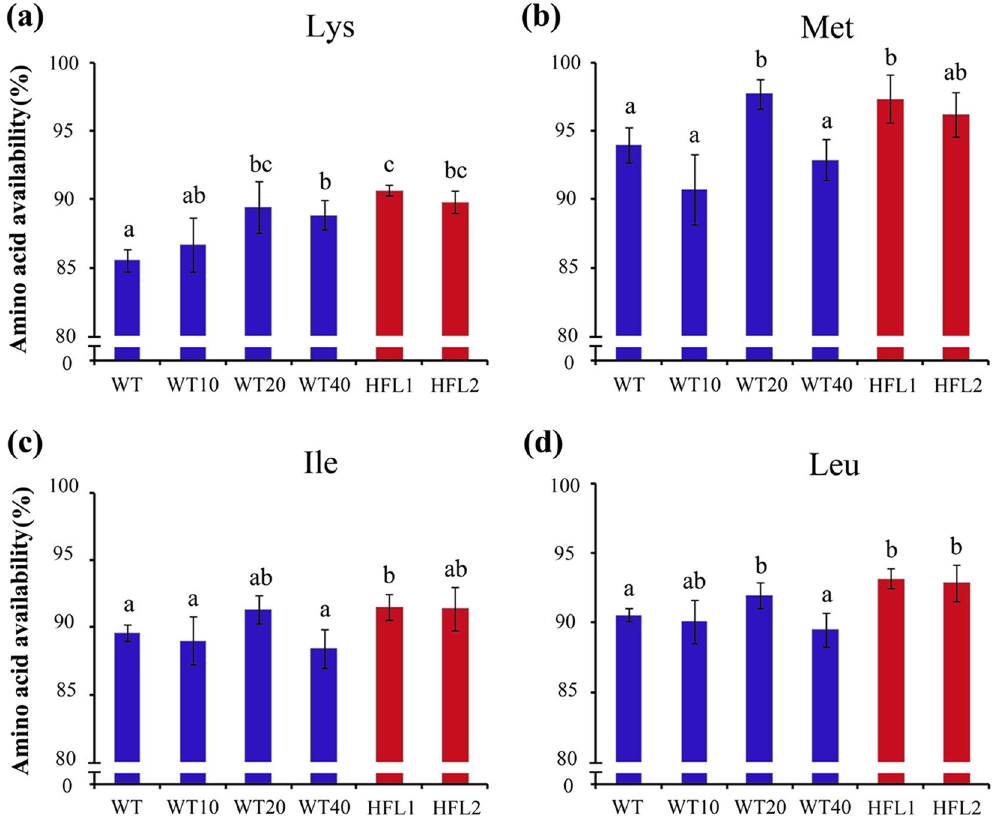
Figure 5. Availability of essential amino acids lysine ( a ), methionine ( b ), isoleucine ( c ), and leucine ( d ) in rats fed different diets. Error bars represent SD (n = 8). Different letters represent significant differences ( P < 0.05).